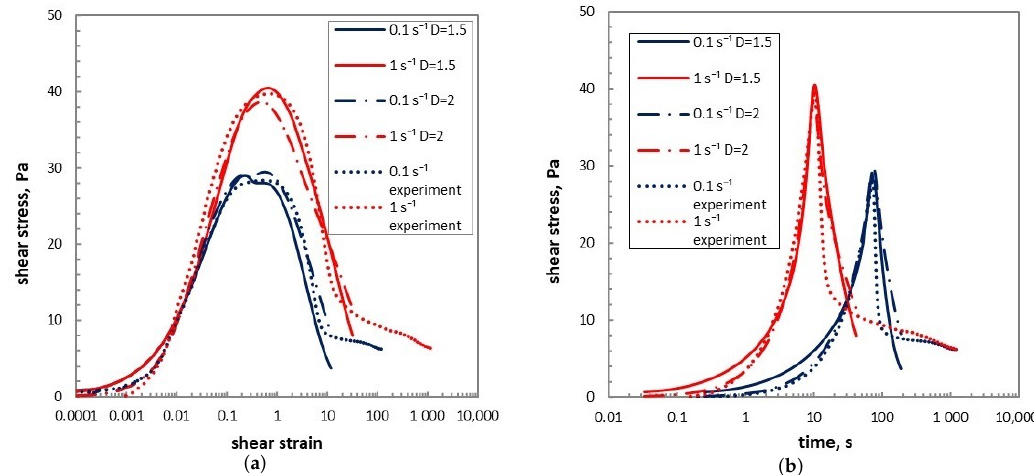
Figure 15. Model predictions of shear stress as a function of shear strain and of time with taking fractal dimensions D = 1.5 and D = 2.0: ( a ) shear stress as a function of shear strain; ( b ) shear stress as a function of